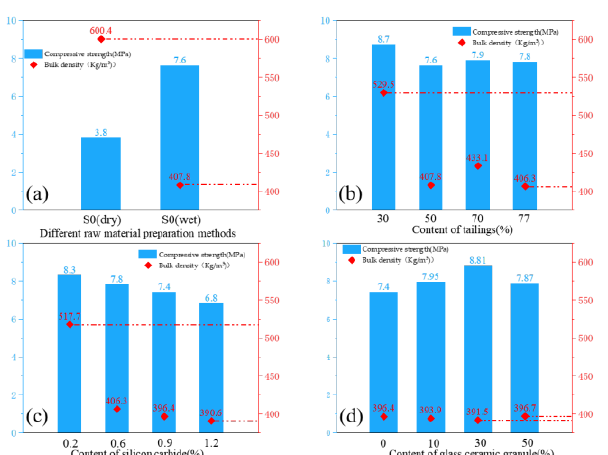
Figure 6. ( a ) Compressive strength and bulk density of different raw material preparation methods; ( b ) Compressive strength and bulk density of different tailings contents (%); ( c ) Compressive strength and bulk density of different silicon carbide contents (%); ( d ) Compressive strength and bulk density of different glass ceramic granule contents (%).